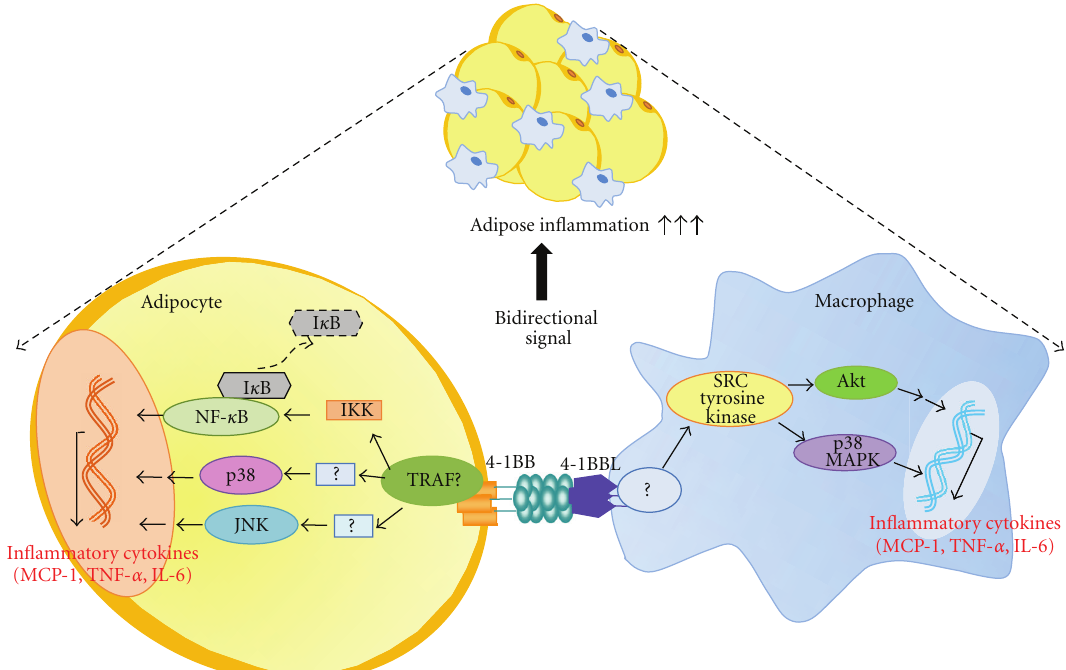
Figure 5: Schematic representation of the bidirectional signal transduction induced by 4-1BB/4-1BBL-mediated interaction between adipocytes and macrophages. The release of inflammatory cytokines (MCP-1, TNF- α , and IL-6) in response to the bidirectional signaling appears to participate in adipose